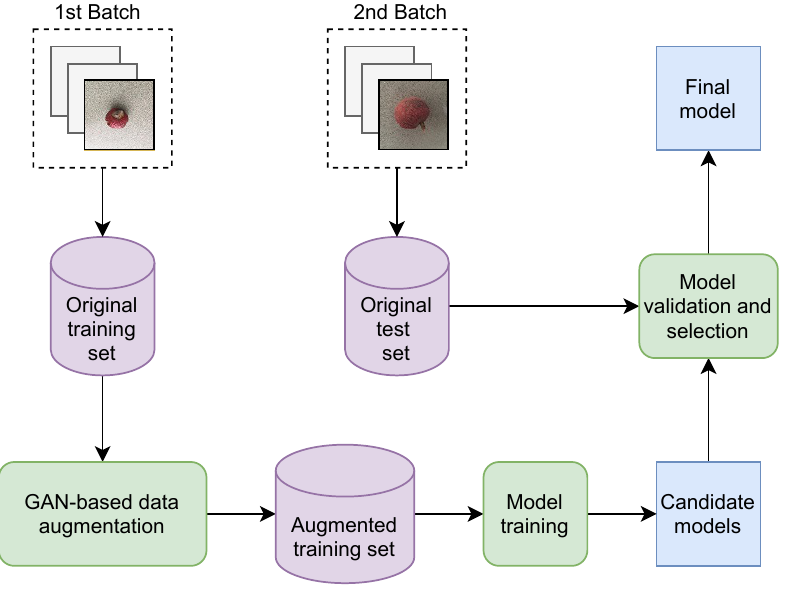
Figure 2. Learning